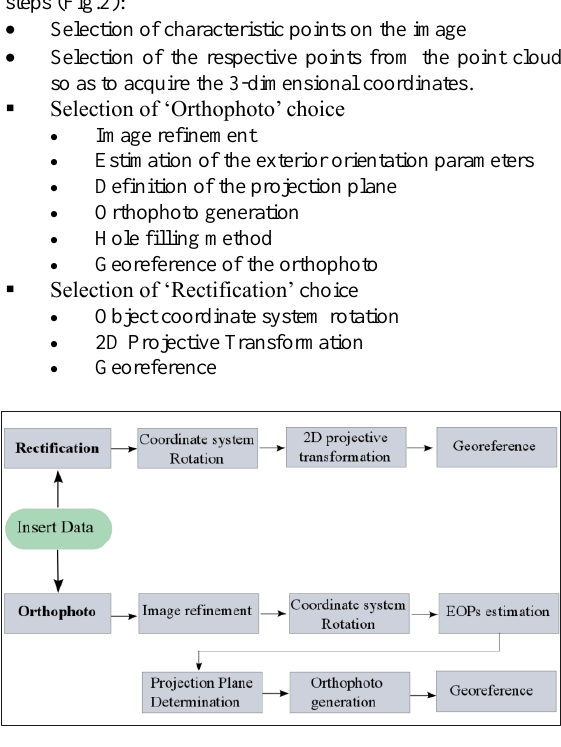
Figure 2: Diagram describing the basic steps of the